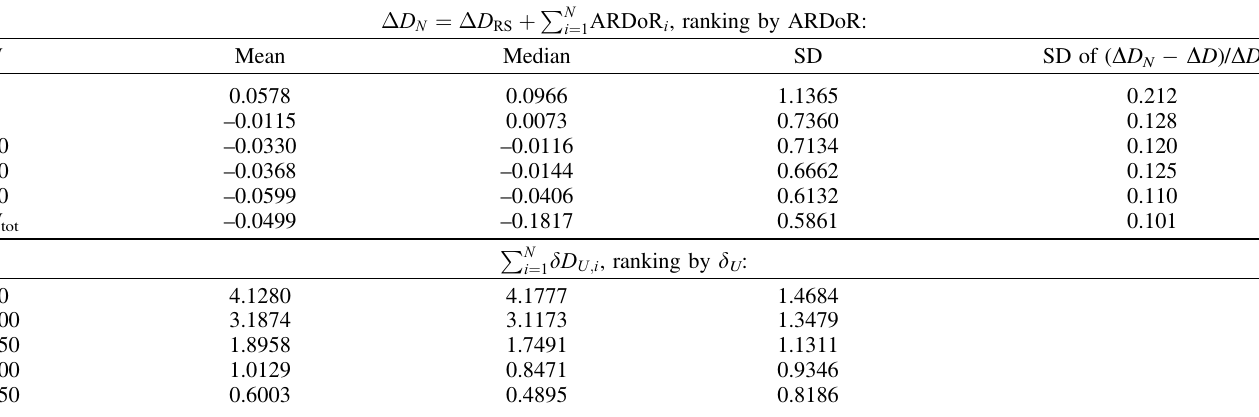
Table 2. Means, medians and standard deviations (SDs) of the residuals of various approximations relative to the simulated value of the absolute dipole moment change D D during an activity cycle, as plotted in Figure